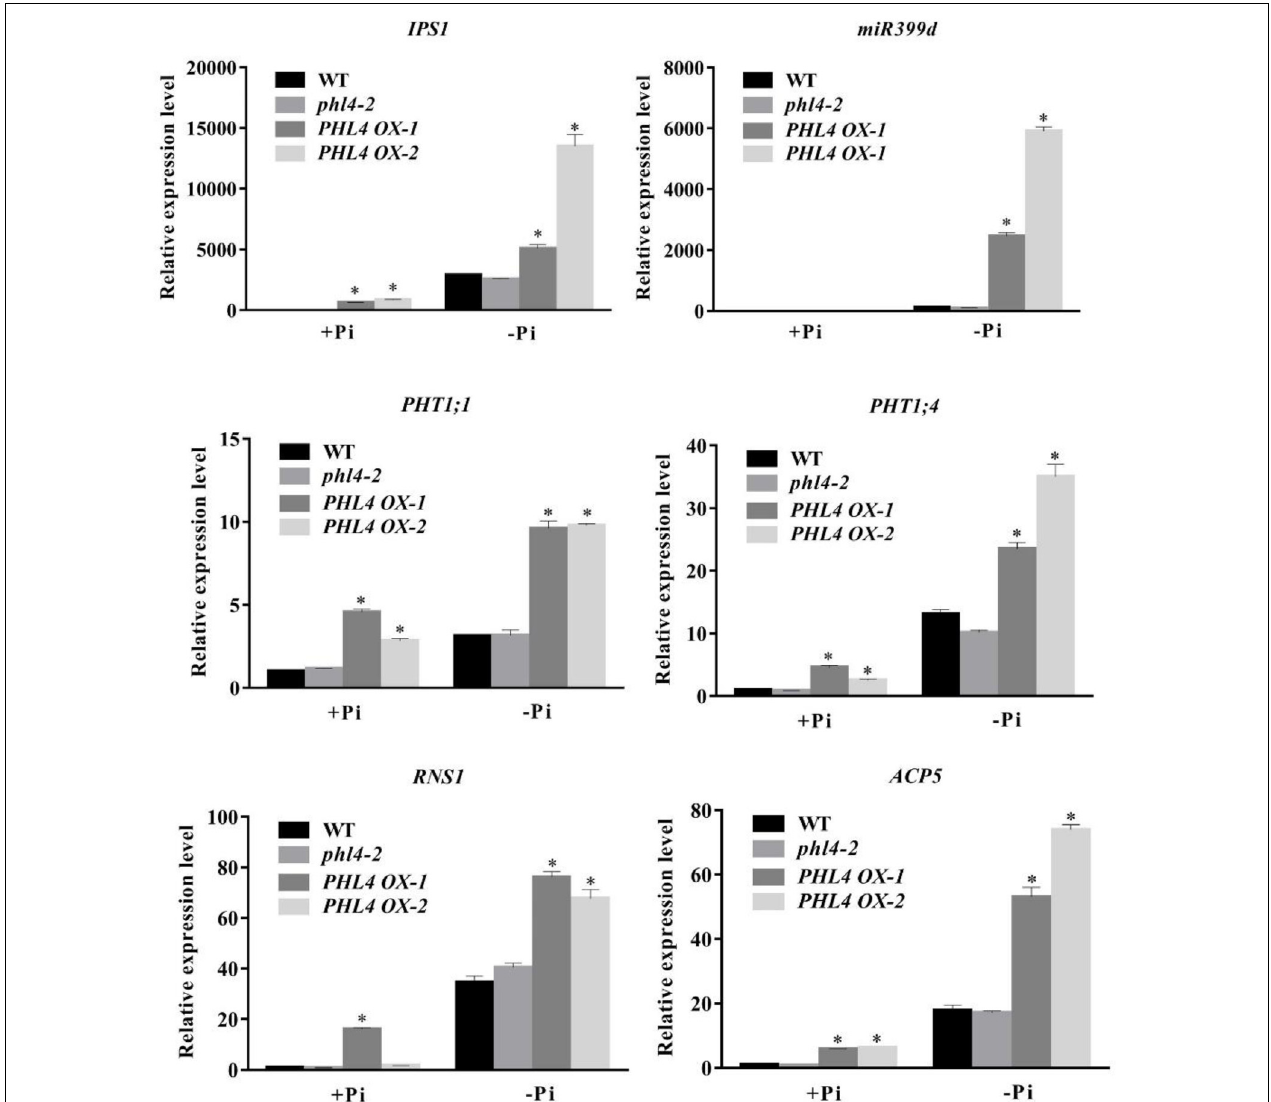
FIGURE 11 | Analyses of PSI gene expression in two PHL4- overexpressing lines ( PHL4 OX-1 and PHL4 OX-2 ). Roots of 8-day-old seedlings of the WT, phl4 , and PHL4 OX-1 and -2 grown on +Pi and –Pi media were used for qPCR analysis. The names of the genes examined are indicated on the top of each panel. Values are the means ± SD of three biological replicates and represent fold changes normalized to transcript levels of the WT on +Pi medium. Means with asterisks are significantly different from the WT ( P < 0.05, t